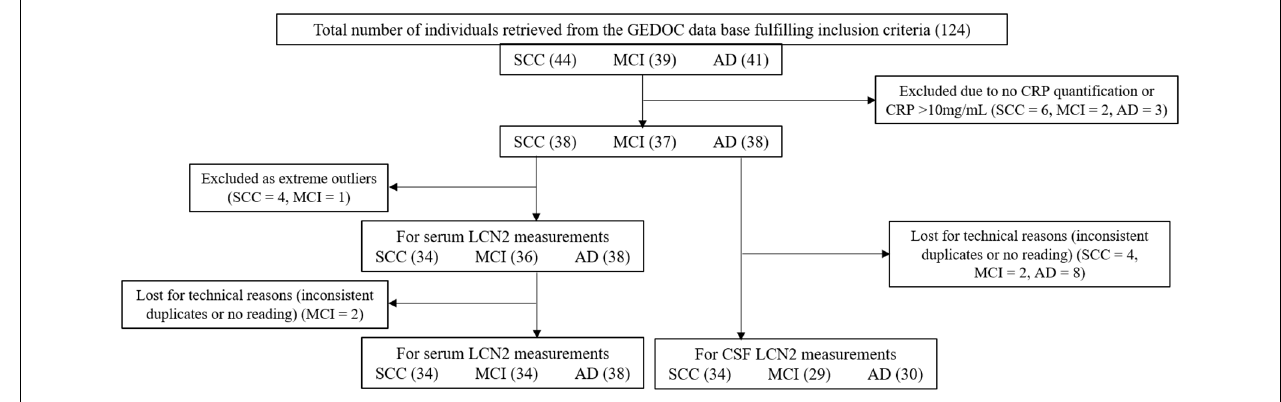
FIGURE 1 | Flow chart of the Swedish study participants.